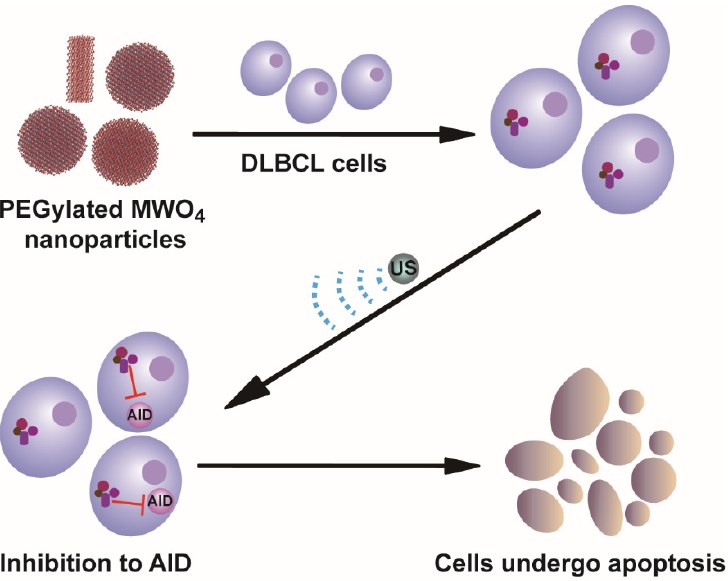
Figure 1. Sonodynamic therapy with the synthetic AID inhibitors (PEGylated MWO 4 ) to AID-positive lymphoma.